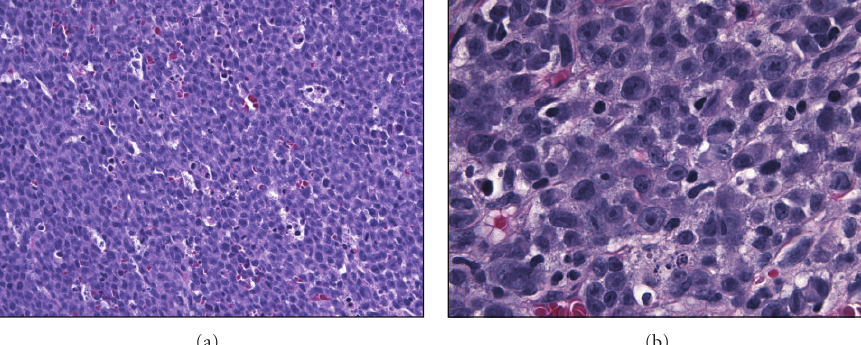
Figure 1: ALK+ LBCL morphology. (a) The tumor grows di ff usely with a sheet-like architecture (400x, H&E). (b) The tumor cells are intermediate to large sized with round nuclei, dispersed chromatin, centrally placed nucleoli and moderate amounts of amphophilic cytoplasm (1000x, H&E).